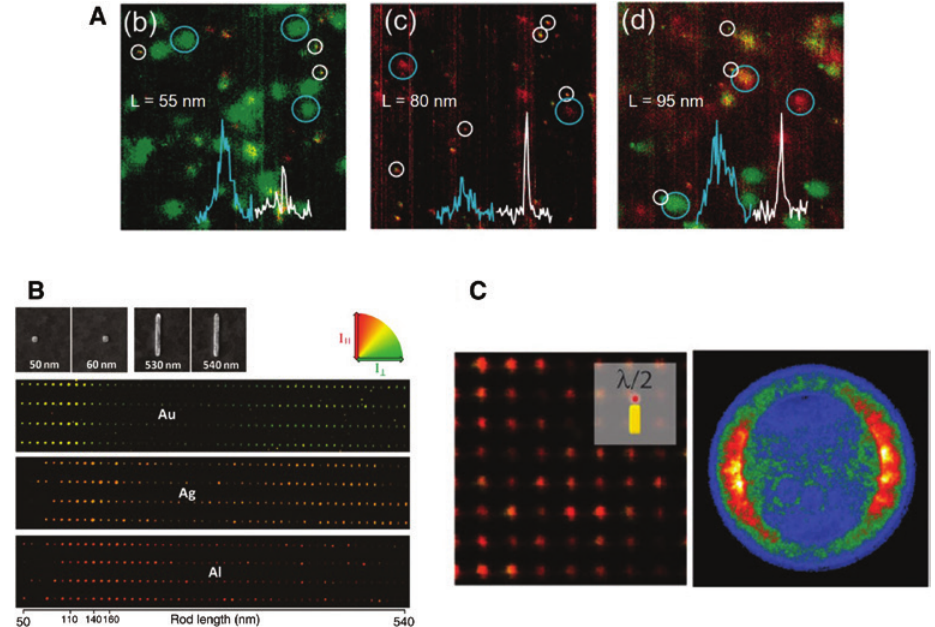
Figure 2: Properties of optical antennas. (A) Resonance property of the optical rod antenna, (B) polarization property of the optical rod antenna, and (C) omnidirectional far-field radiation pattern of the optical rod antenna. (A) Reprinted with permission from Ref. [10]. Copyright 2007 American Chemical Society. (B) Reprinted with permission from Ref. [27]. Copyright 2011 American Chemical Society. (C) Reprinted with permission from Ref. [29]. Copyright 2010